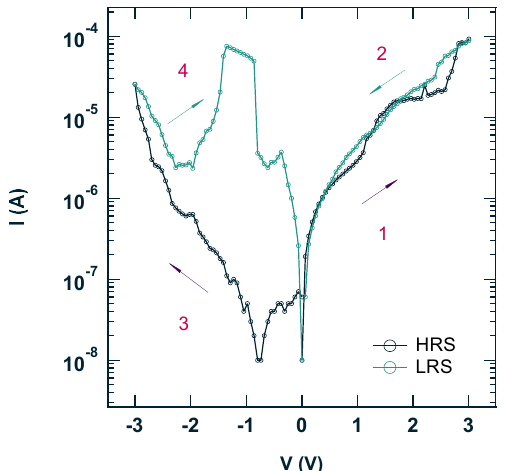
Figure 1. Initial sweep of the ITO / ReO 3 @ReS 2 / Al memcapacitor, measured at a frequency ( f ): 0.6 Hz. Sweeping voltage range: ± 3 V, and compliance current ( I cc ): 1 × 10 − 2 A. Arrows indicate voltage sweep sequence.